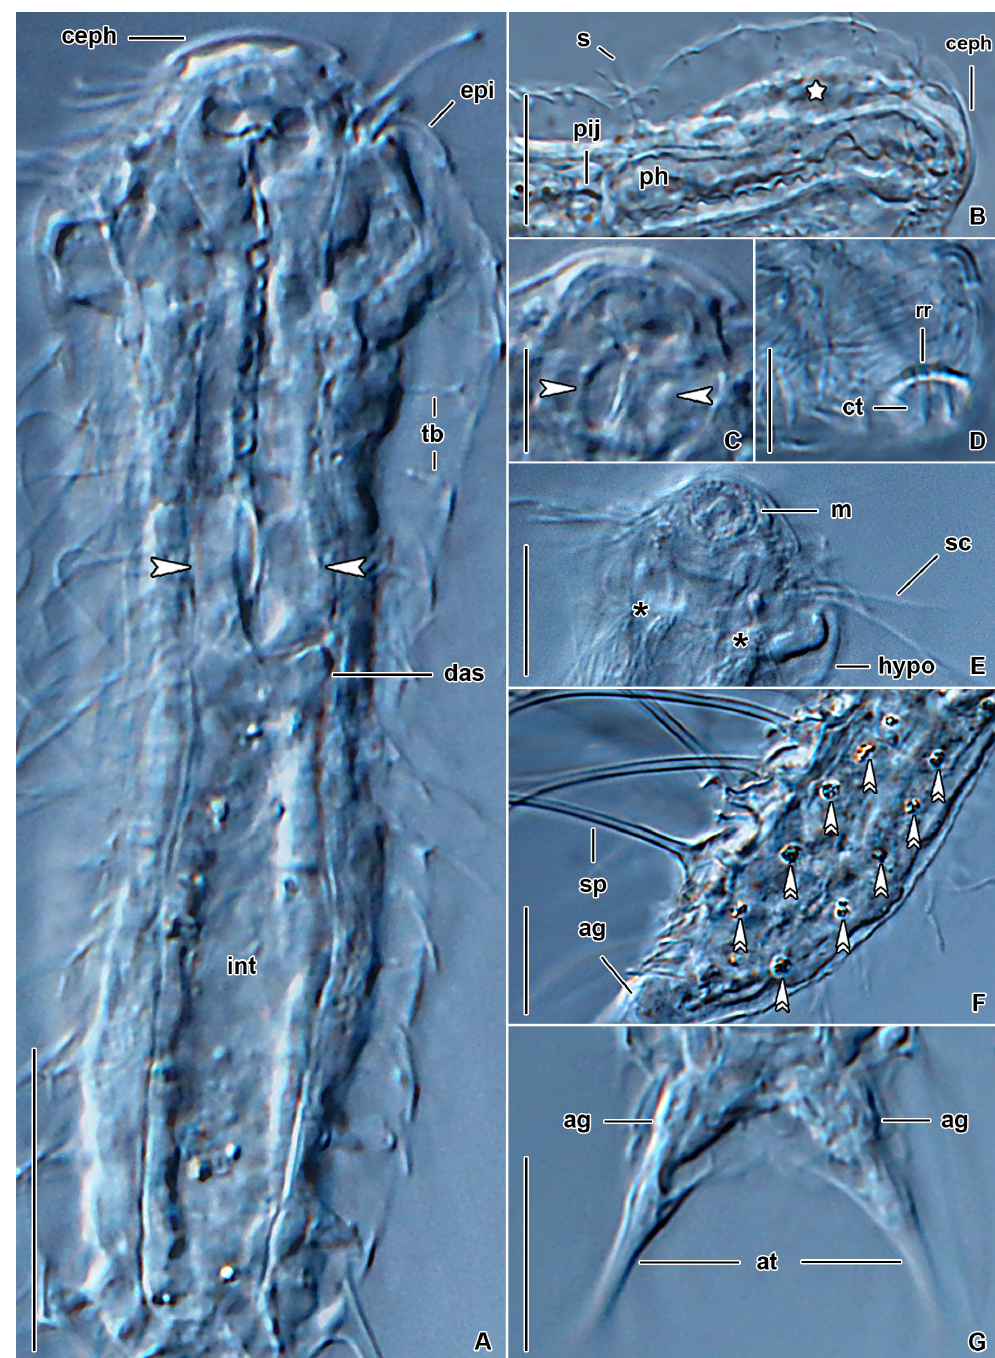
Fig. 13. Chaetonotus ( Hystricochaetonotus ) mirabilis sp. nov., differential interference contrast. A, C, E, G . Paratype (CU-FNS-25-10-19/PA-1). B, D, F . Paratype (CU-FNS-02-10-19/PA-2). A . Internal morphology. Opposed arrowheads denote posterior pharyngeal dilatations. B . Lateral view of the anterior body region. White star marks the cerebral ganglion. C . Anterior pharyngeal dilatations (opposed arrowheads). D . A pair of cuticular teeth is situated in the center of the mouth ring. E . Ventral view of the head region. Asterisks mark the beginning of the ventral ciliary bands. F . The intestine contains highly refractive and regularly arranged structures (white double arrowheads). G . Furca with a U-shaped indentation and adhesive glands. Scale bars: A = 15 µm; B, E–G = 10 µm; C–D = 5